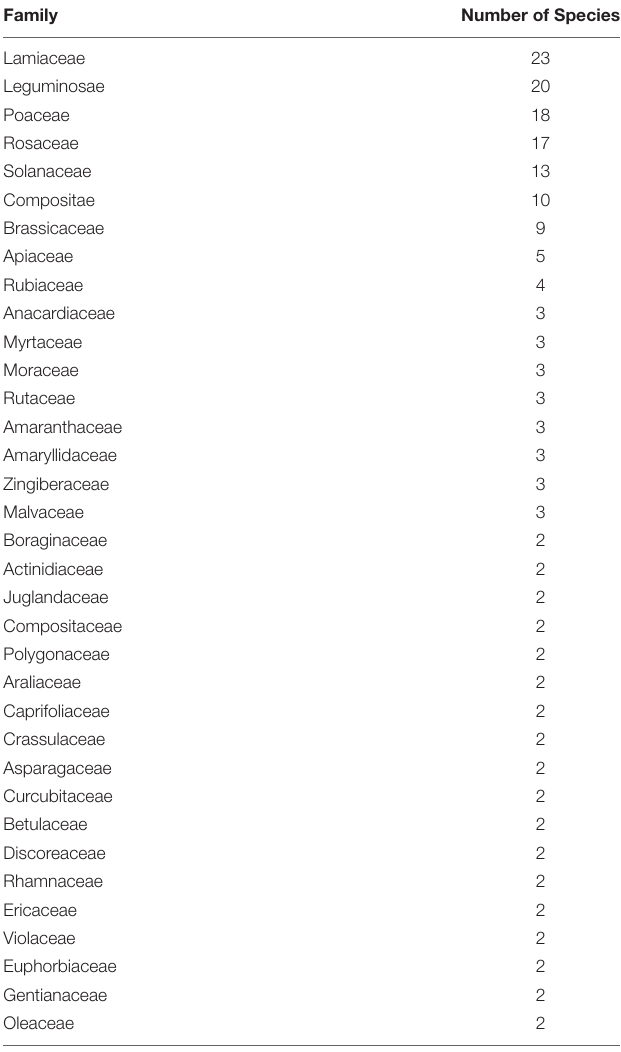
TABLE 2 | Summary of families in which melatonin has been investigated.